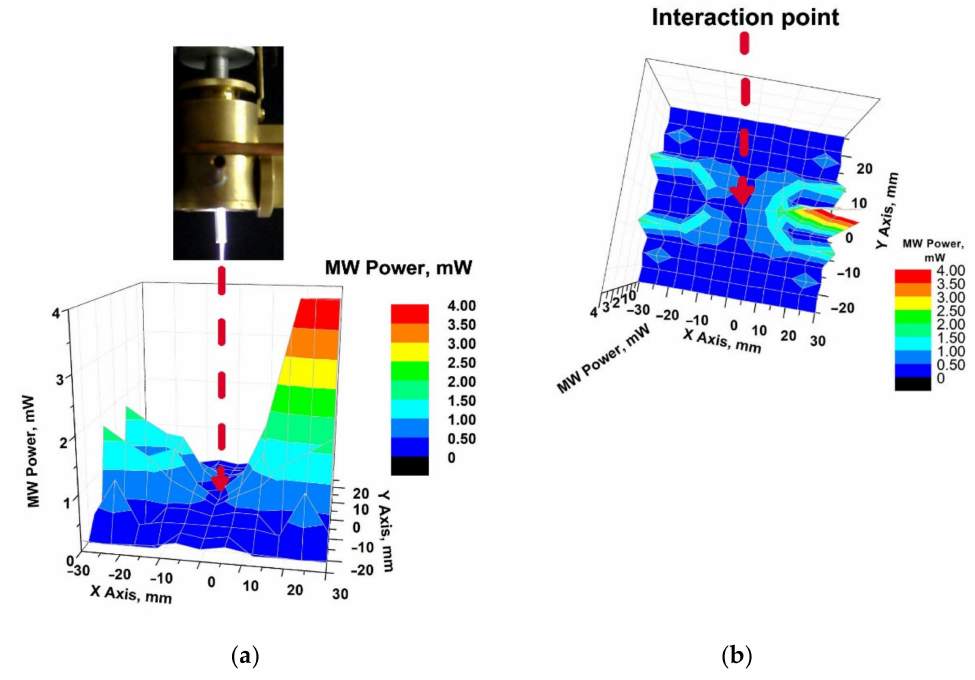
Figure 11. Microwave radiation distribution around the sample position at wave frequency 2.45 GHz, wave power 9 W, reflected power less than 1 W, discharge tube 8/3, argon flow 7 L/min: ( a ) side view; ( b ) top